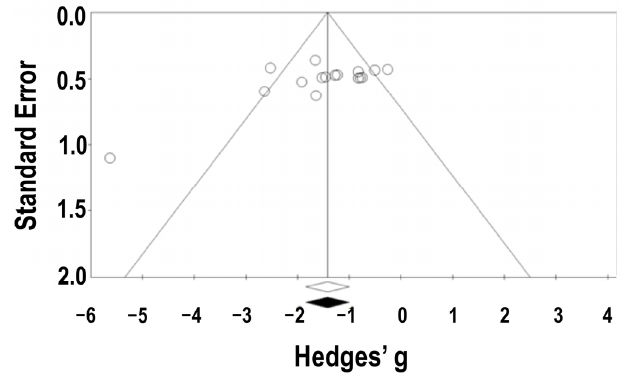
Figure 4. Funnel plots of standard error and Hedges’ g of BG levels in DM rodents given either A. lappa and arctigenin-related compounds or vehicles. Open and closed diamonds indicate the im- puted overall estimates before and after Duval and Tweedie’s Trim and Fill adjustment, respec-